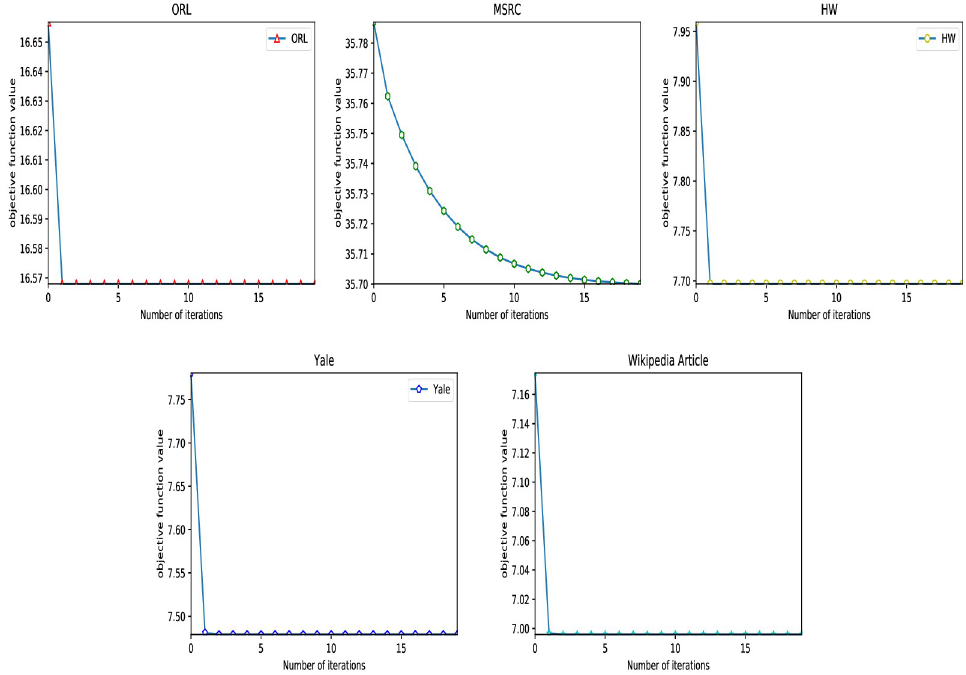
Fig 9. The change of the objective function value of RMVCP-2 on five data sets of ORL, MSRC, HW, Yale, and Wikipedia Article.